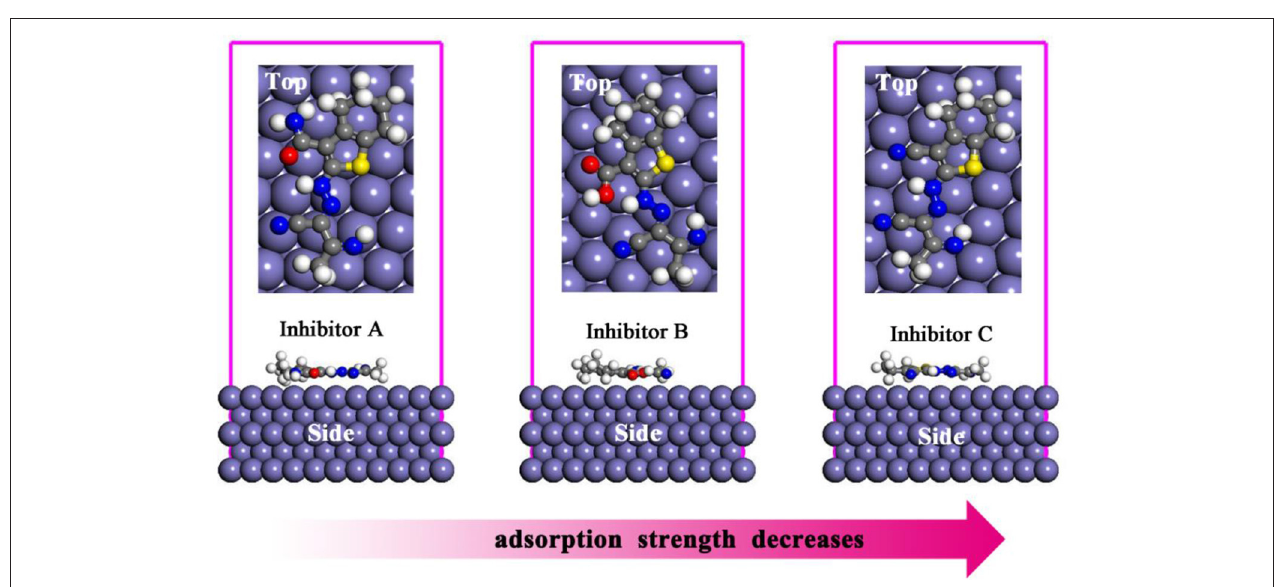
FIGURE 5 | Side and top views of the most stable adsorption models of three inhibitors on Fe(110) surfaces.